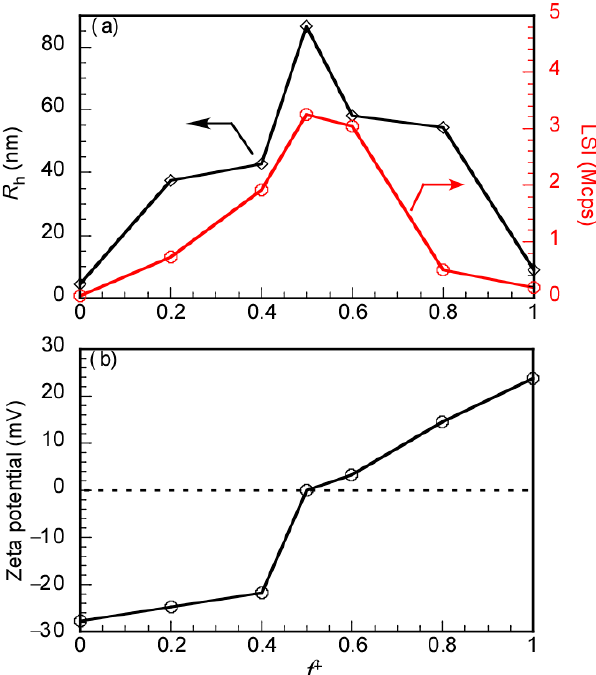
Figure 3. ( a ) Hydrodynamic radius ( R h , diamond) and light scattering intensity (LSI, circle) and ( b ) zeta-potential for the P(VS) 17 A 50 /PAAc 49 PIC vesicle at C p = 0.1 g/L in water at pH 10 as a function of f + at 25 °C.